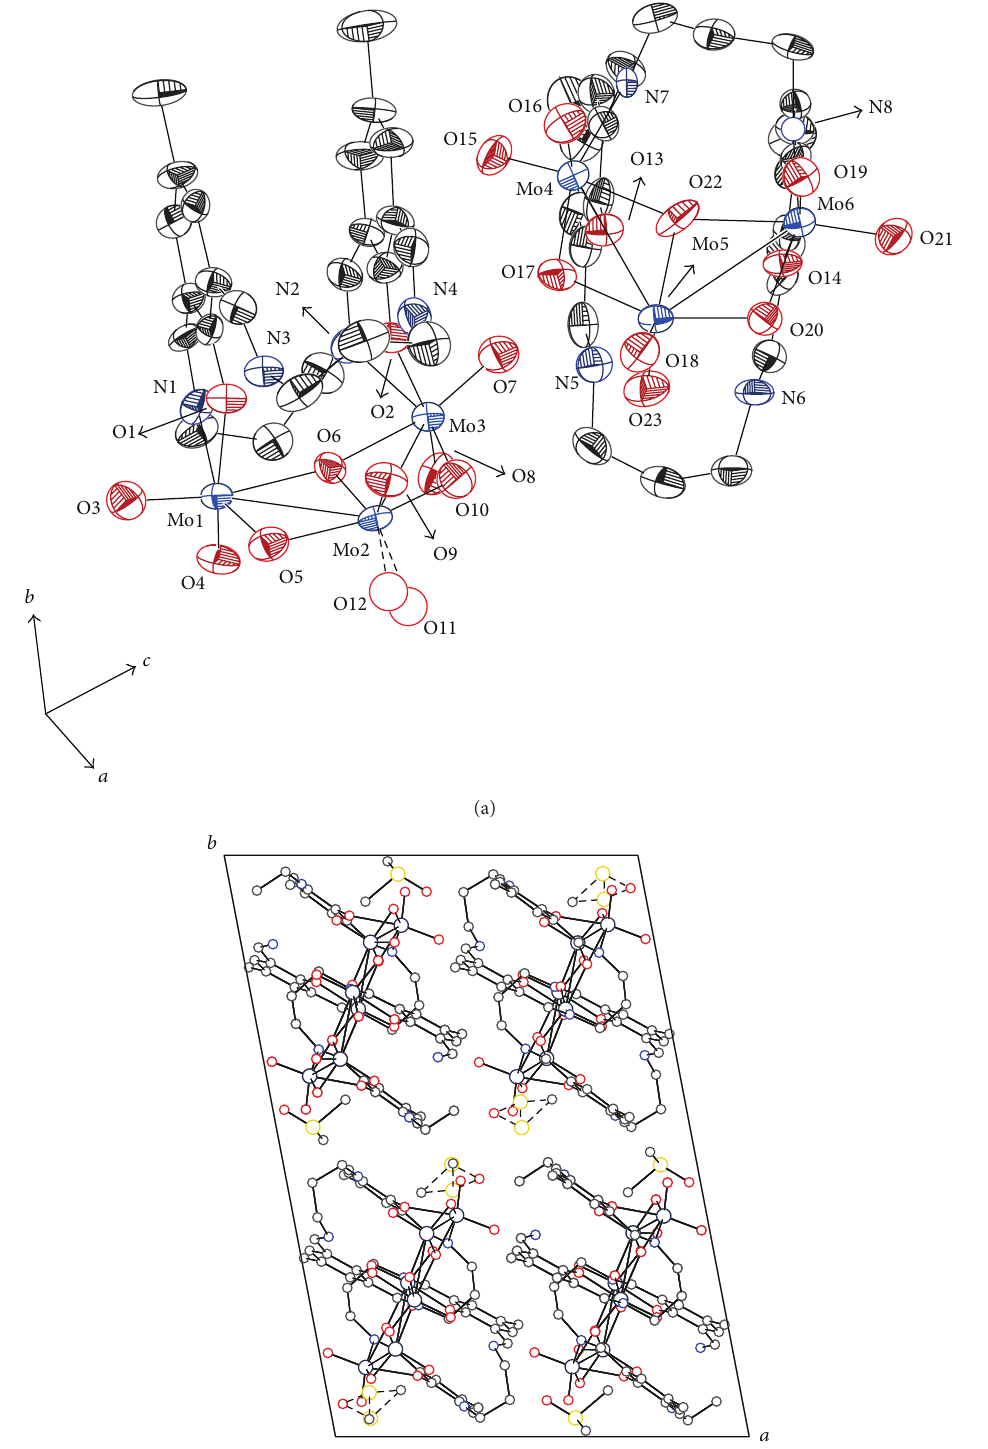
Figure 2: Molecular structure with the atom-labeling scheme. (a) Ellipsoids of the asymmetric unit drawn at 50% probability level. The dmso and the hydrogen atoms were omitted for sake of clarity. (b) Packing of complex 1 along the b -axis the hydrogen atoms were omitted for sake of